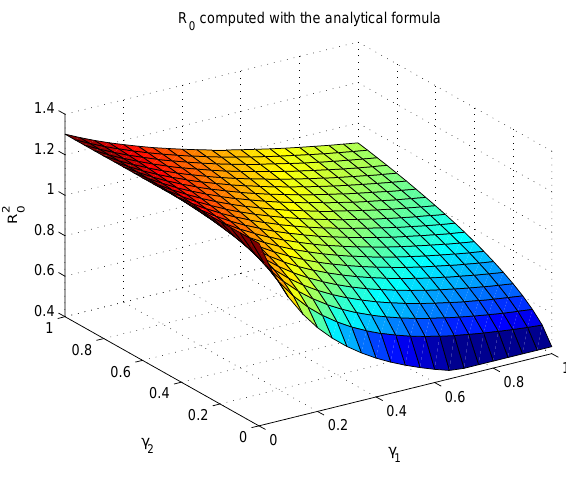
Fig. 4. Evolution of R 2 0 with respect to γ 1 and γ 2 Fig. 5. Simulation of the evolution of the infected population per week for different values of γ .